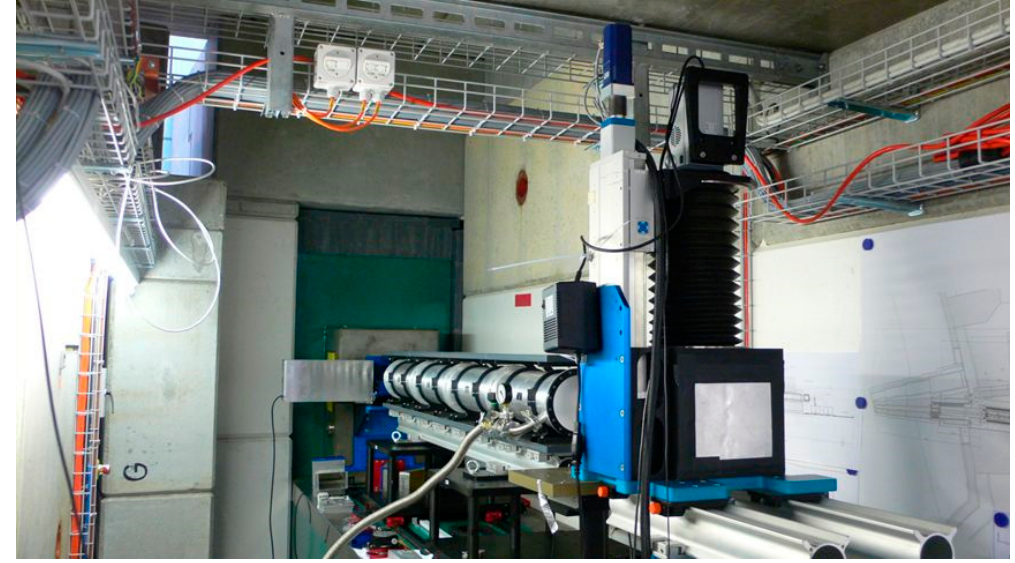
Figure 2 . The camera based detection system MIDI (medium size) for samples up to 15 cm, here installed at the BOA test beam line [9] of the Swiss spallation neutron source SINQ.